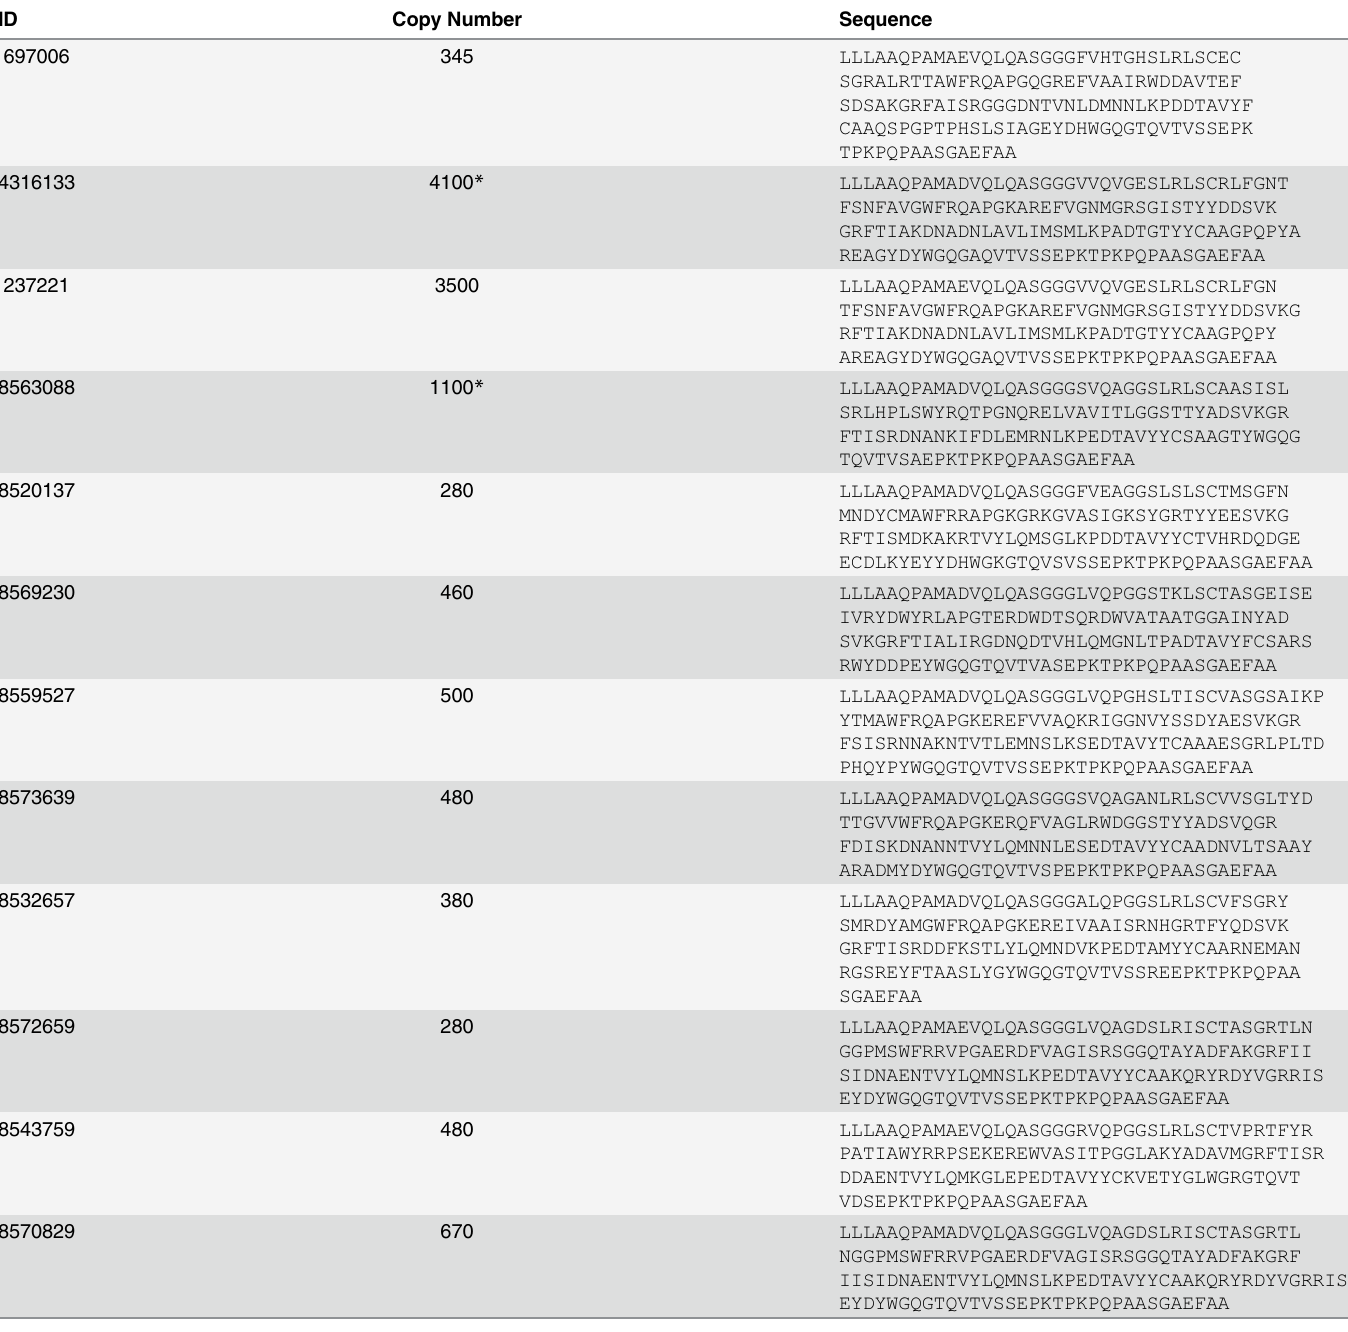
Table 3. Sequences of high-copy-number